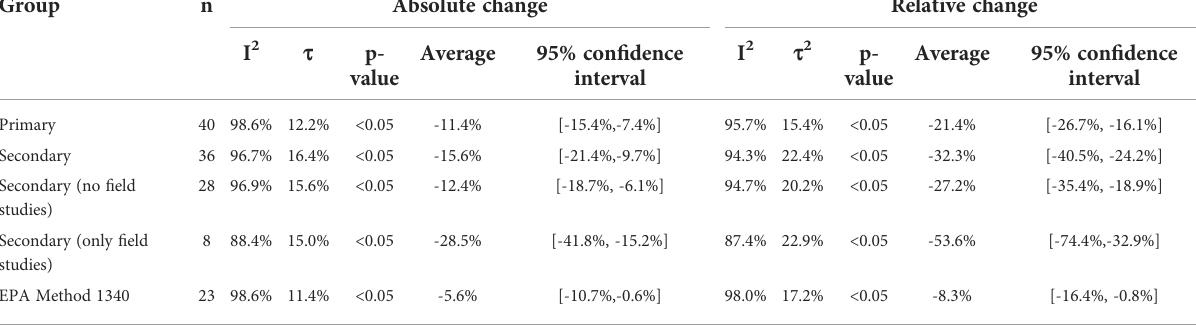
TABLE 2 Summary of pooled treatment effect via random effects model for each analysis group.